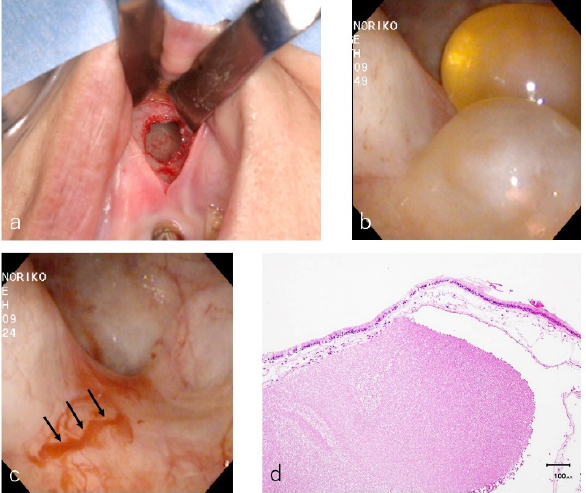
Figure 2. The same case as Figure 1. After a vertical incision, an intentional perforation of the sinus membrane was performed through the window ( a ). Two yellowish transparent cysts were observed by the endoscope ( b ) and were removed at the superior layer of the periosteum which contained blood vessel (( c ), black arrows). Histological examination of a hematoxylin and eosin staining slide demonstrated a single layer of ciliated columnar epithelium and connective tissue with slight degree of inflammatory cells. Among the connective tissue, eosinophilic content was observed, and the diagnosis was an antral pseudocyst ( d ).